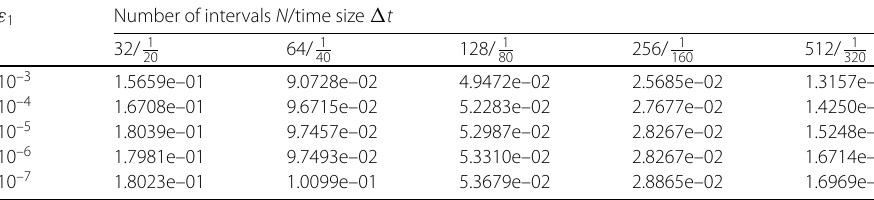
Table 3 Maximum error E N , M ε for Example 5.1 using the adaptive grid method with ε 2 = 10 –2